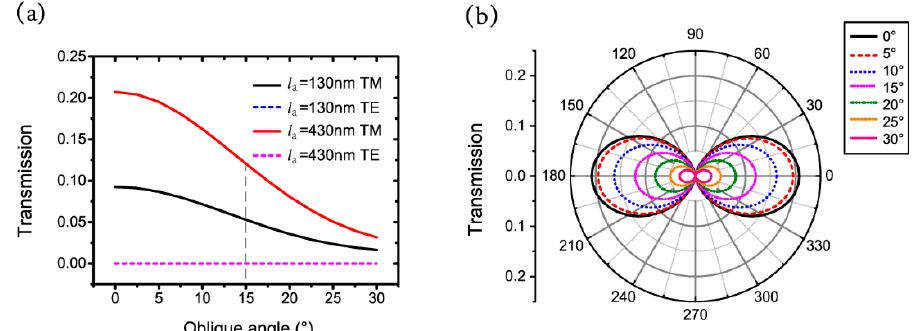
Figure 6. ( a ) Transmissions with di ff erent θ at l a = 130 nm and l a = 430 nm for TM and TE polarizations; ( b ) transmission with di ff erent polarization angles for di ff erent θ at l a = 430